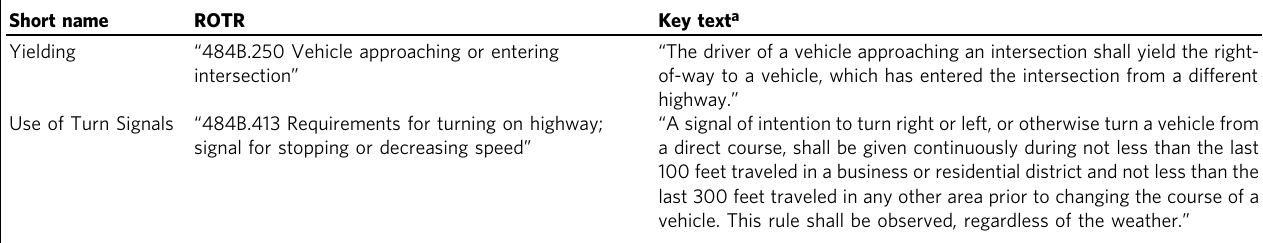
Table 2 Selected ROTRs for the study (verbatim text from Chapter 484B — Rules of the Road (Nevada Legislature, 2022b)). Short name ROTR Key text a Yielding “ 484B.250 Vehicle approaching or entering intersection ” highway.